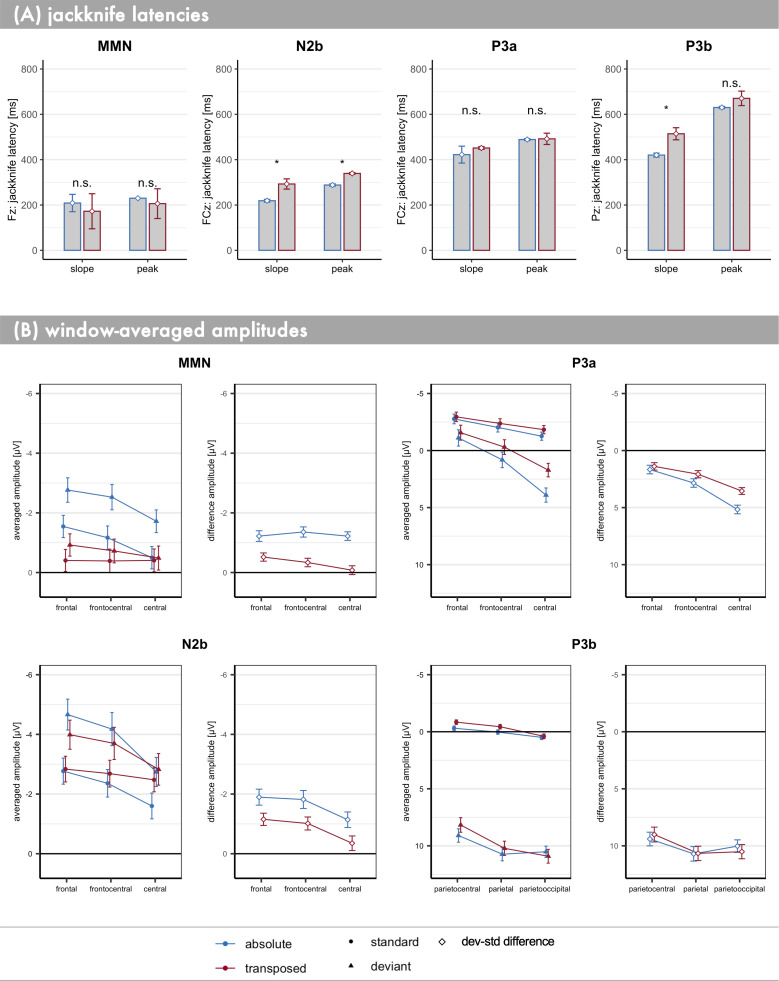
Error bar plots of averaged ERP component latencies and amplitudes.Condition is coded by colour (blue: absolute, red: transposed). Error bars represent ± 1 SEM. For exact values please refer to Table 1. (A) Jackknife latency estimates of slope (60% of the local peak) and peak (100% of local peak) in each condition for each ERP component respectively. Note that different electrodes were used for the components (y-axis label). Significant differences (padj ≤ .05) are marked with an asterisk. (B) For each component window-averaged amplitudes are depicted both on the stimulus as well as the deviant-standard difference level from anterior to posterior electrodes along the midline, though averaged across the lateral dimension within a 3x3 electrode array.